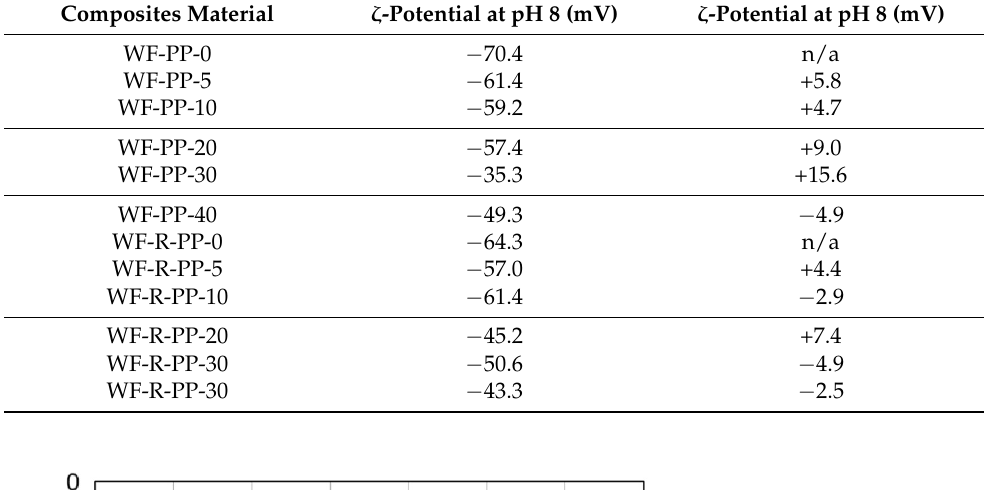
Table 2. ζ -potential for PP and R-PP-softwood fiber composites and deviation between measured and predicted results (assuming a weighted average of the zeta potential for PP and R-PP and spruce, respectively).